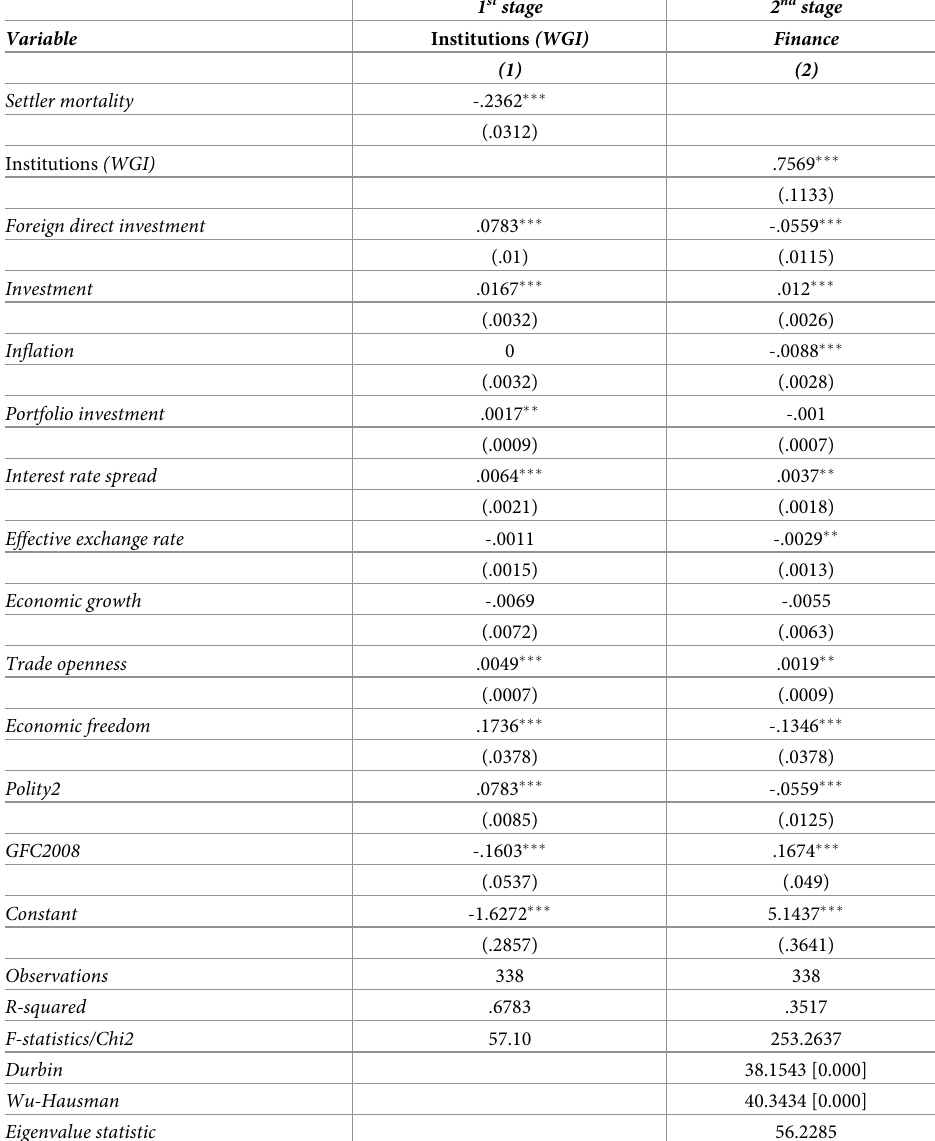
Table 4. Impact of institutions on finance - 2SLS